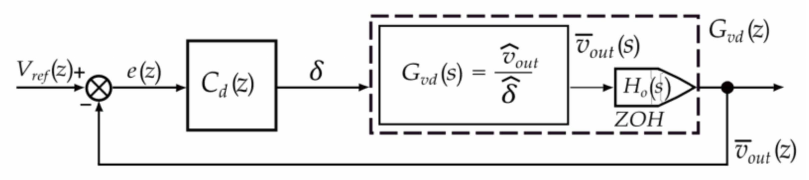
Figure 6. Control block scheme using OCL model method.